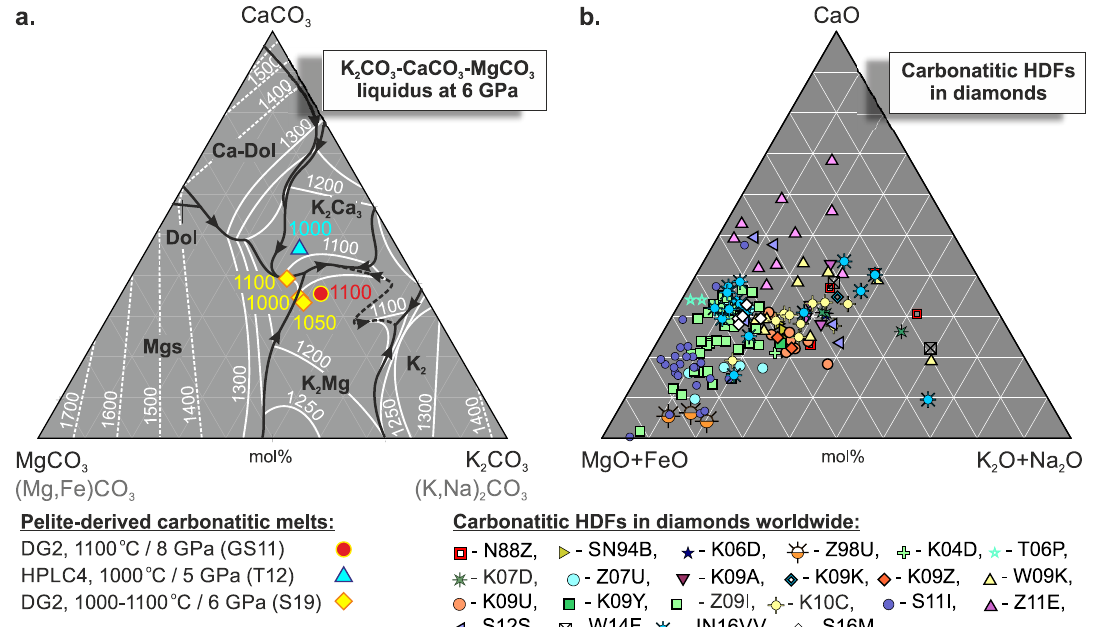
Figure 10. Comparison of the liquidus relationships established in the K 2 CO 3 – CaCO 3 – MgCO 3 system with the compositions of pelite-derived melts ( a ) and carbonatitic HDFs in diamonds worldwide ( b ). N88Z — fibrous (cubic and coated octahedral) diamonds from Zaire and Botswana [18]; SN94B — fibrous diamonds with cubic morphology from Jwaneng, Botswana [19]; Z98U — K-Cr-rich aluminosilicate melt inclusions (up to 150 μm in size) in ‘monocrystalline’ octahedral diamonds of peridotitic suite from Udachnaya kimberlite pipe [69], K04D — a coated diamond from the Diavik mine in Canada containing peridotitic minerals [70]; K06D — fibrous (cubic and coated octahedral) diamonds from the Diavik mine in Canada and the Yubileinaya mine in Russia [71]; T06P — coated diamonds (eclogitic and peridotitic) from the Panda kimberlite in Canada [25]; K07D — fibrous diamonds from the Diavik mine, Canada [72]; Z07U — cuboid fibrous diamonds from the Udachnaya kimberlite, Russia [73]; K09A, K09K, K09U, K09Y, K09Z — fibrous diamonds with cubic morphology from the Aykhal Komsomolskaya, Udachnaya, Yubileinaya, Zarnitsa kimberlite pipes, Russia [21]; W09K — coated octahedral diamonds from Kankan, Guinea [22]; Z09I — cuboid diamonds with fibrous inner zone from Internatsional’naya kimberlite pipe, Russia [20]; S11I — cloudy diamonds from the Internatsional’naya pipe, Russia [74]; Z11E — fibrous diamonds with cubic and semi rounded morphology from the Ebelyakh River placer deposits, Russia [75]; S12S — fibrous diamonds from the 2.701 – 2.697 Ga Wawa metaconglomerate, Canada [76]; W14F — a coated diamond from Finch mine, South Africa [77]. JN16VV — along (111) twinn ing surfaces in ‘monocrystalline’ octahedral diamonds of peridotitic suite from South Africa's Venetia and Voorspoed mines [28]; S16M — cloudy diamonds from the Mir kimberlite pipe, Russia [23].